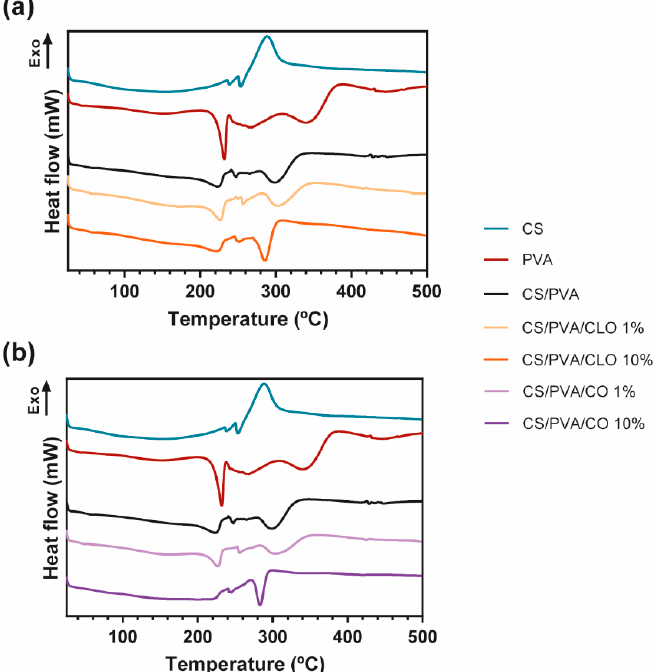
Figure 6. ( a ) Representative DSC thermograms emphasizing ( a ) CLO- and ( b ) CO-loaded CS/PVA blended films, and respective controls, from 25 to 700 °C, and performed at a heating rate of 10 °C/min in a nitrogen atmosphere.